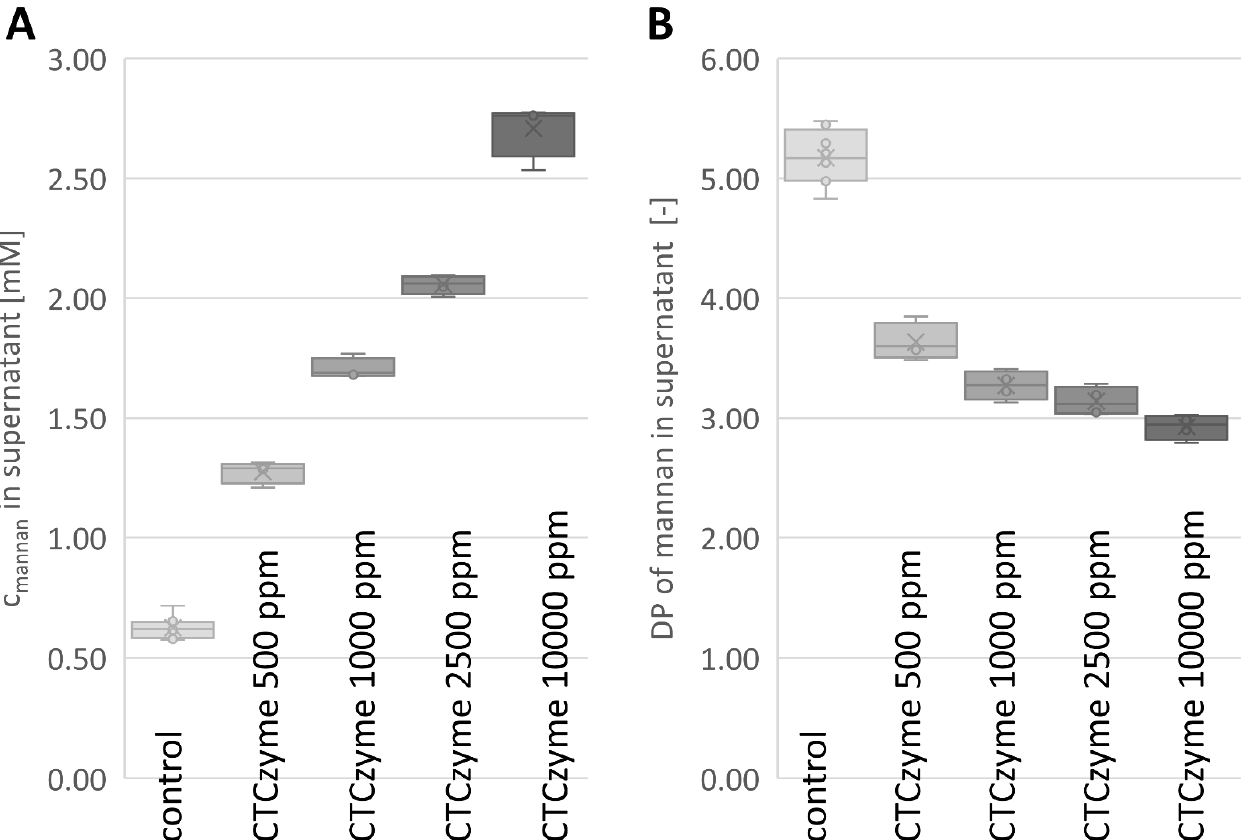
Figure 2. 1 H-NMR spectra of anomeric region of mannan. The control sample is shown in black. Colored spectra show the sample after treatment with different concentrations of B. subtilis man- nanase. 1 ppm equals 1 µg of commercial enzyme preparation per kg of PKC. The commercial dos- age is 500 ppm. The NMR resonances used for integration are marked: H α red denotes the anomeric hydrogen atom of the reducing end mannose moiety in α -configuration, H β red denotes the anomeric hydrogen atom of the reducing end mannose moiety in β -configuration and H β nonred denotes the anomeric hydrogen atoms of all other mannose units.